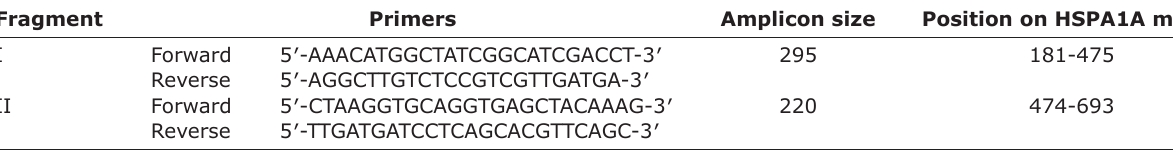
Table-1: Primer sequences used to amplify HSP70 gene of Tharparkar cattle.